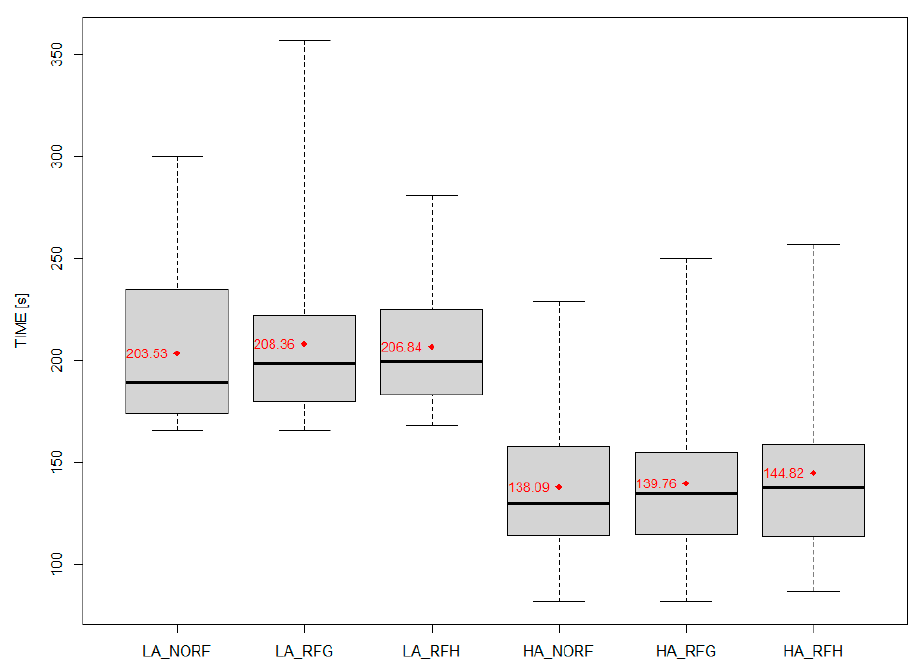
Figure 6. Boxplots of the completion times for all conditions (with red circles marking and labeling the mean values of the completion times).